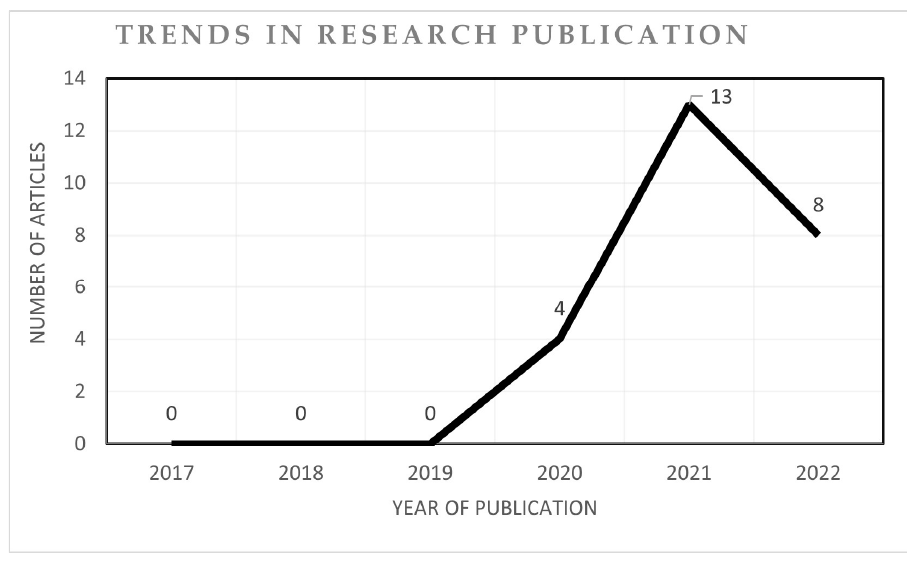
Figure 2. Trends in Research Publication.